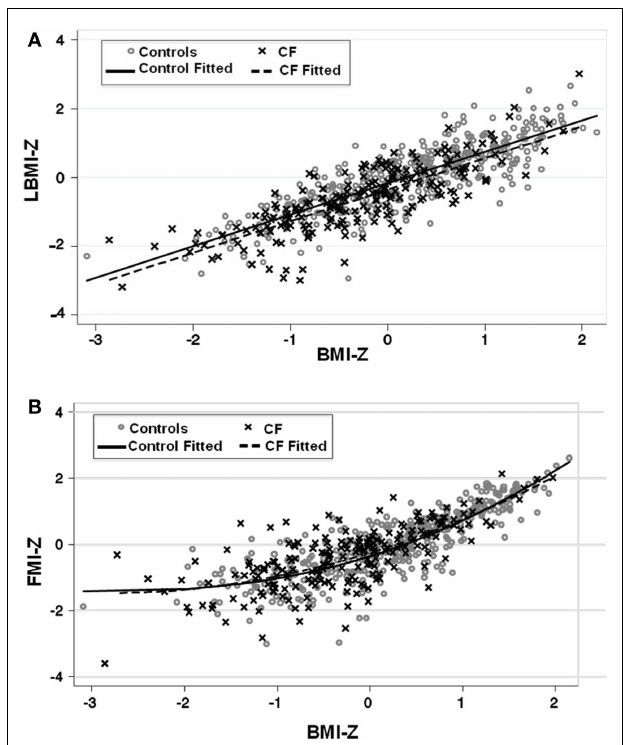
FIGURE 1 | (A) The association between LBMI- Z and BMI- Z among healthy controls and patients with CF.There is a positive association between LBMI- Z and BMI- Z in all patients. Patients with CF have lower LBMI- Z for BMI- Z compared to controls. (B) The association between FMI- Z and BMI- Z among healthy controls and patients with CF.There is a positive association between BMI- Z and FMI- Z in all patients that is not altered in the presence of CF. Circles represent data points for controls and the solid line represents the fitted line for controls. Crosses represent data points for CF patients and the dashed line represents the fitted line for CF subjects.